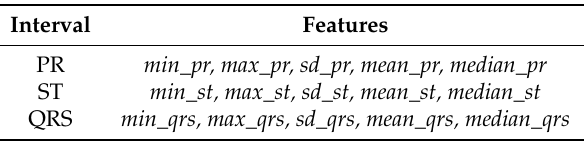
Table 3. With-in beat